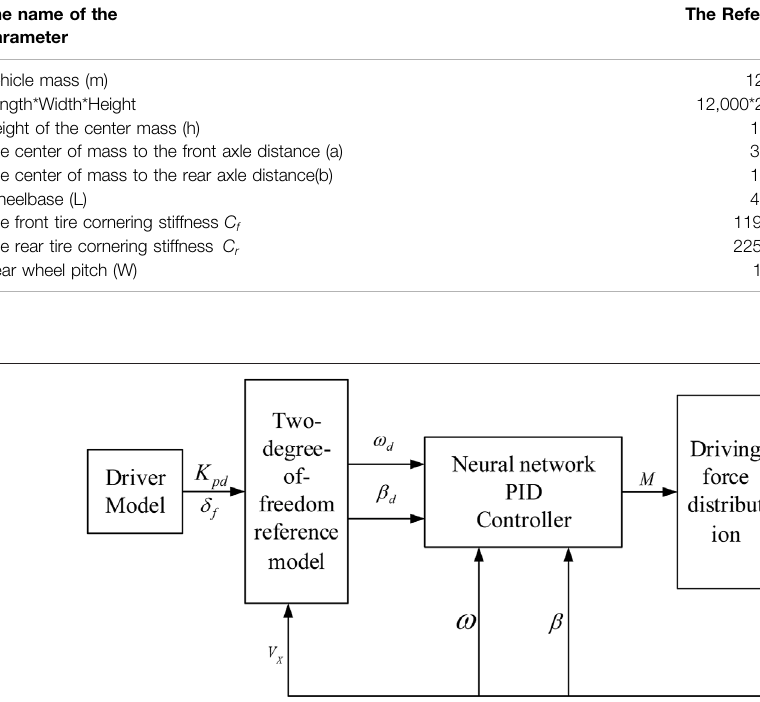
FIGURE 3 | Direct yaw moment control fl ow chart.